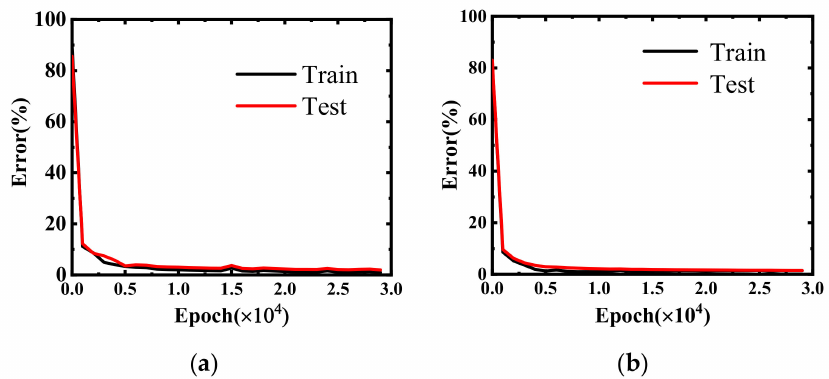
Figure 9. Impact ionization coefficient prediction error during the model training process and testing: